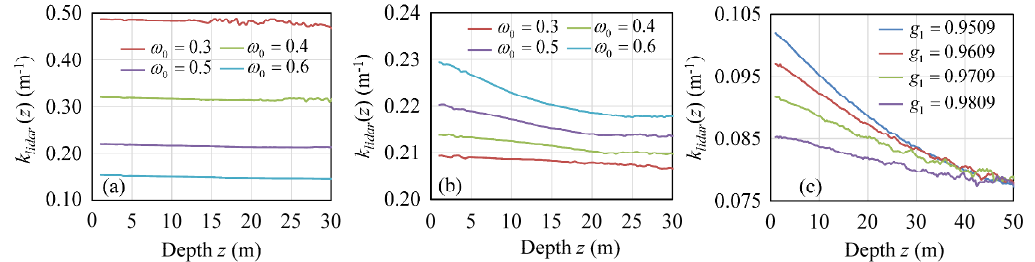
Figure 3. The influence of IOPs on k lidar for (a) 1 0.2m b   and [Chl]=0.35 mg/m 3 and g 1 =